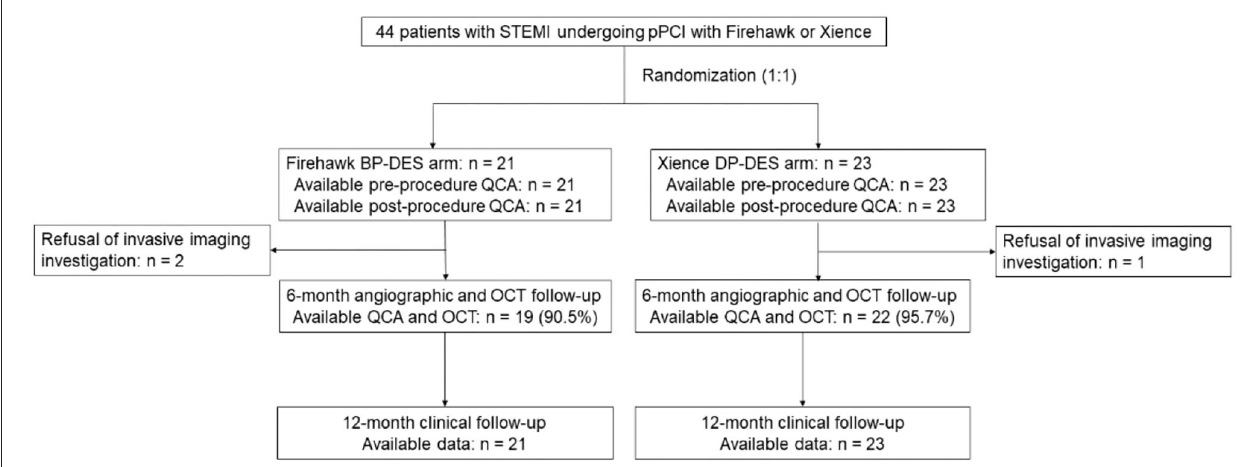
FIGURE 1 | Study flowchart. BP-DES, biodegradable polymer drug-eluting stent; DP-DES, durable polymer drug-eluting stent; OCT, optical coherence tomography; pPCI, primary percutaneous coronary intervention; QCA, quantitative coronary angiography; STEMI, ST-segment elevation myocardial infarction.